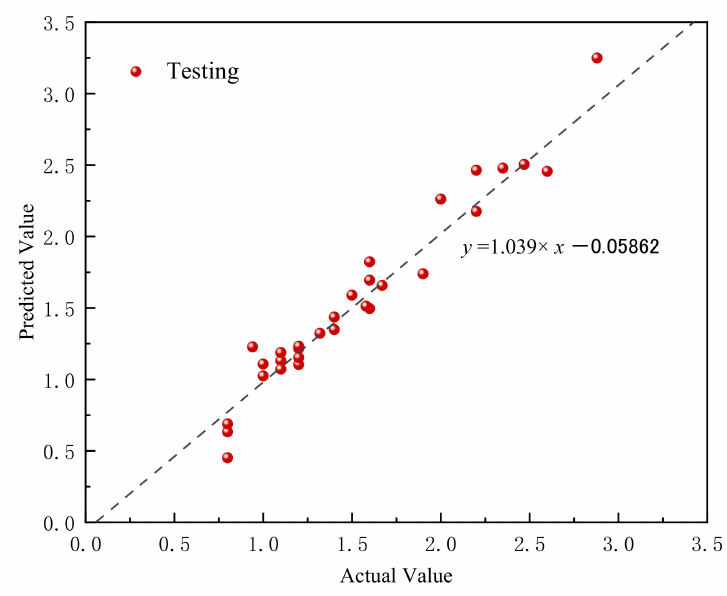
Figure 12. Predictive performance of SSA-ENN model.